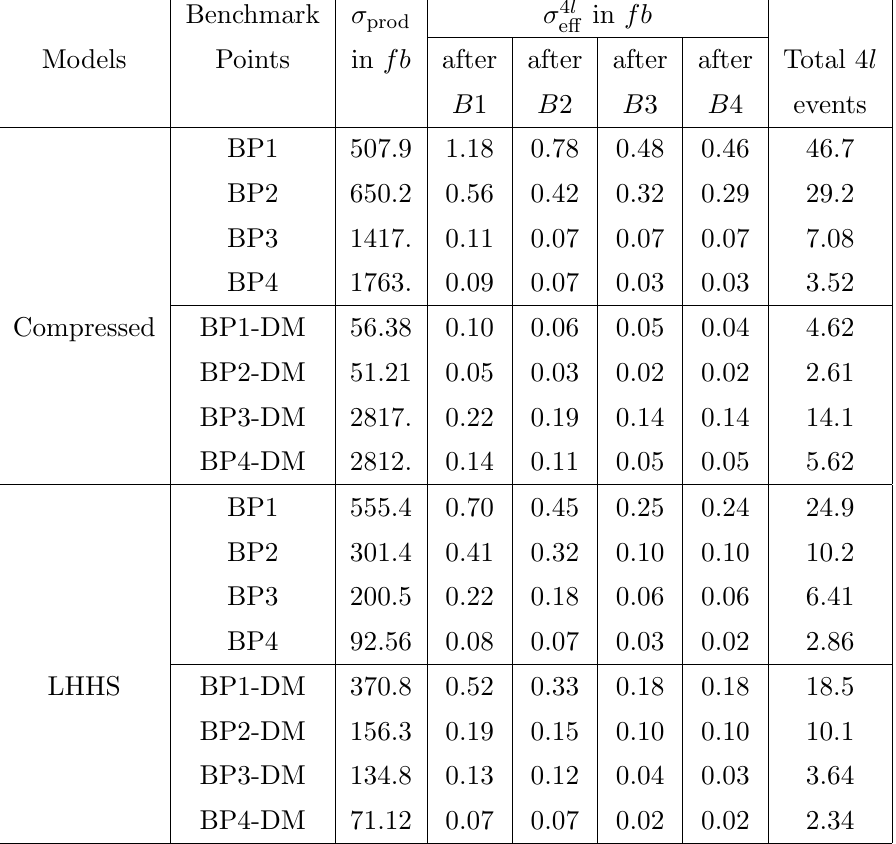
Table 12 . The production cross-sections of all EWeakino pairs and (cid:27) 4 l and table 6. Also the total number of 4 l events are shown for an integrated luminosity of 100 fb (cid:0) 1 .